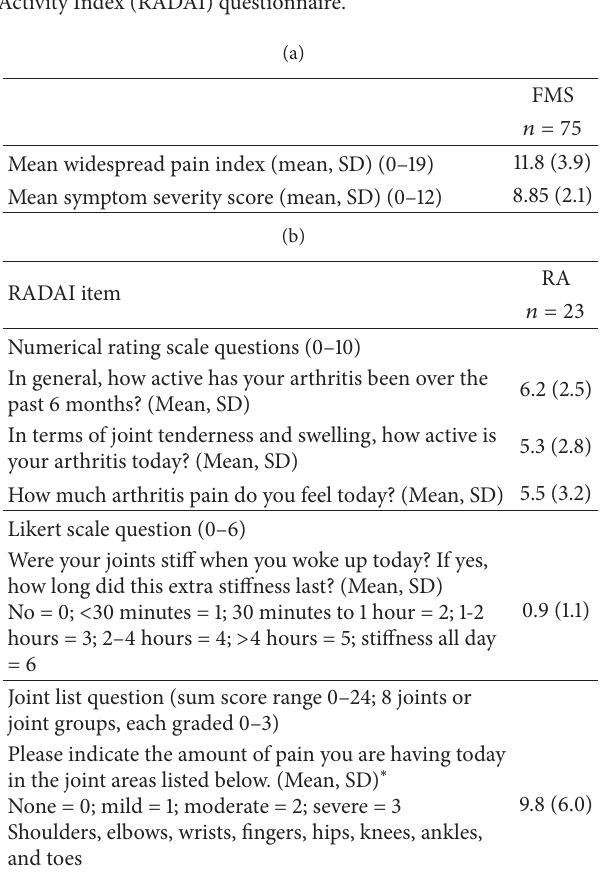
Table 3: (a) Clinical data of Israeli FMS patients assessed by widespread pain index and symptom severity score. (b) Clinical data of Israeli RA patients assessed by Rheumatoid Arthritis Disease Activity Index (RADAI) questionnaire.